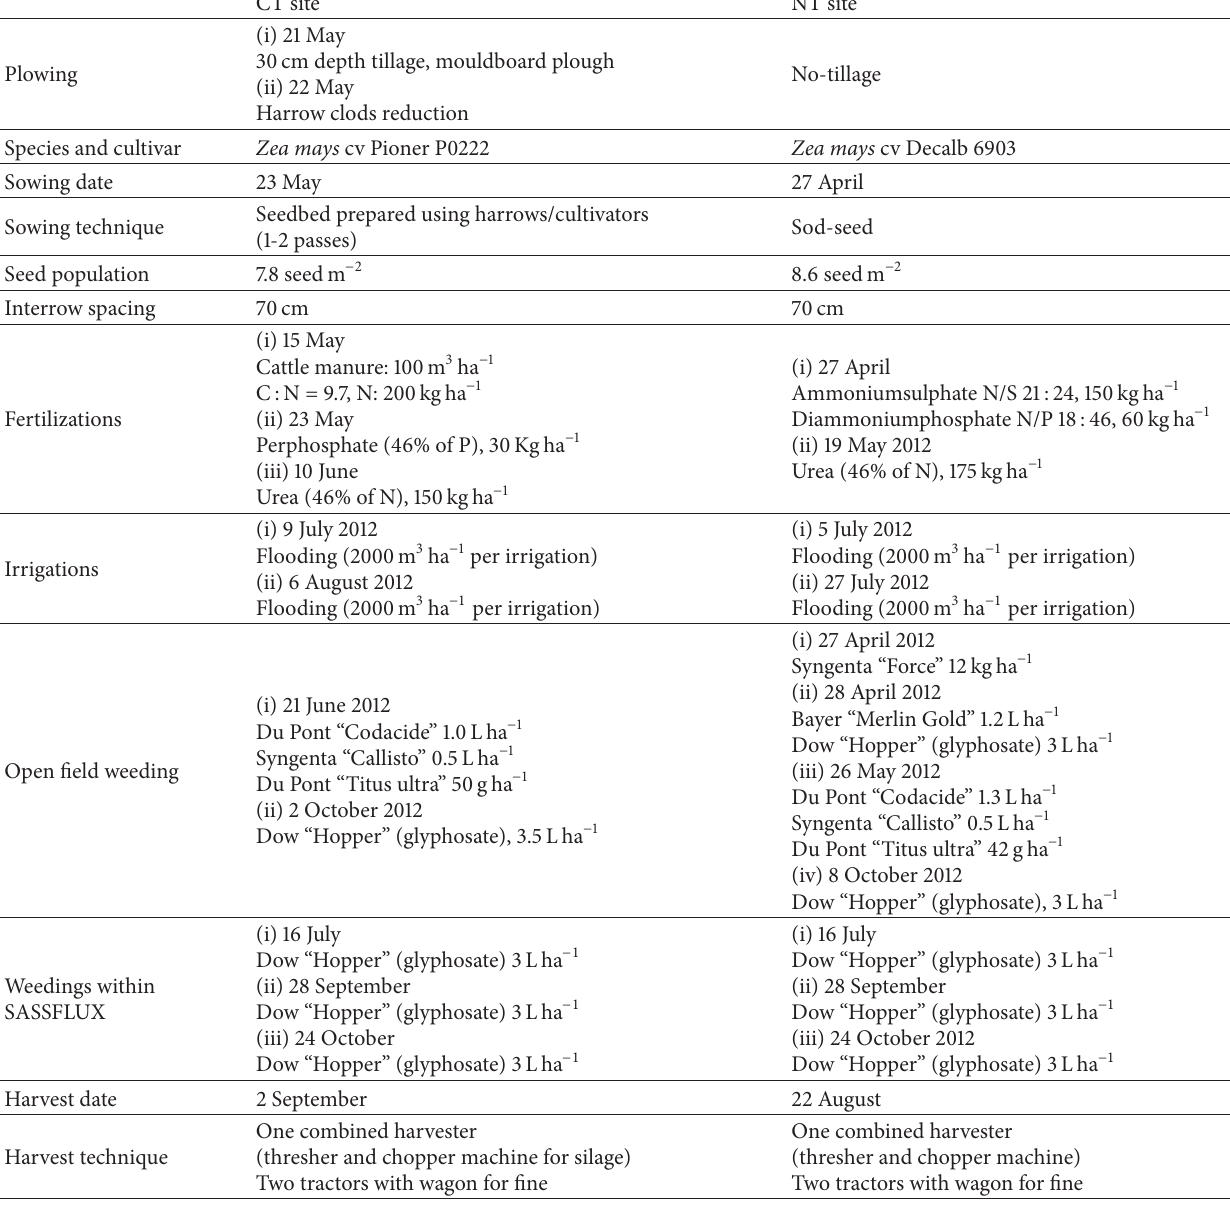
Table 1: Crop management practices in the two sites (CT = conventional tillage site, NT = no-tillage site). All dates are referred to year